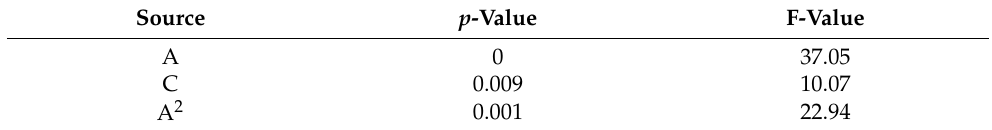
Table 2. Analysis of variance of the model estimating the diameter of